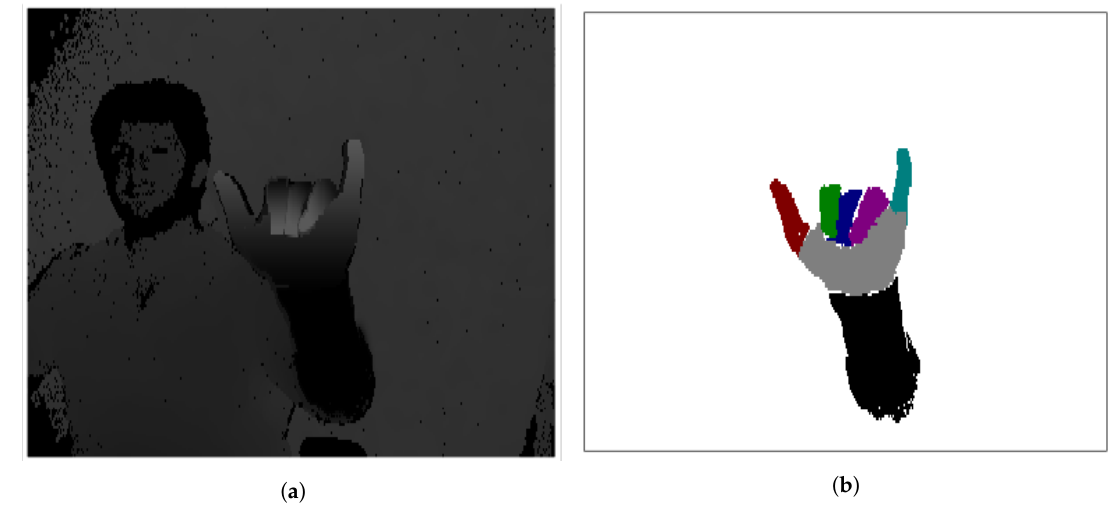
Figure 9. Hand depth data ( a ) and hand component label ( b ) in the FingerPaint dataset.